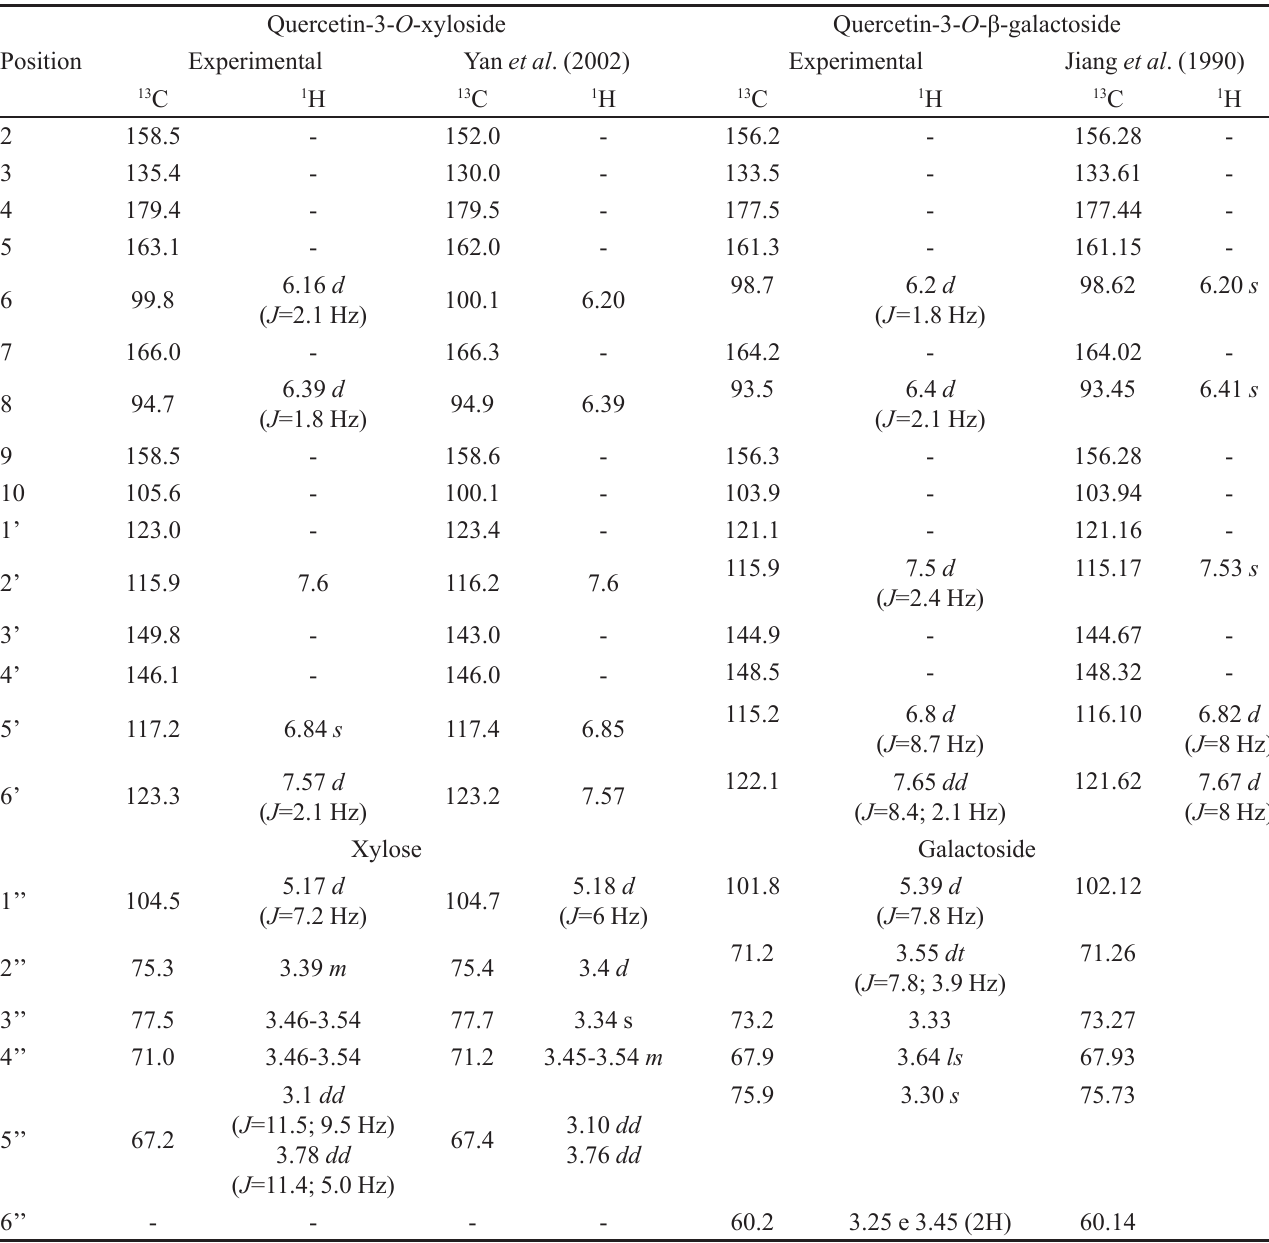
TABLE III - Compounds 4 and 5 NMR (ppm) experimental data compared against literature data